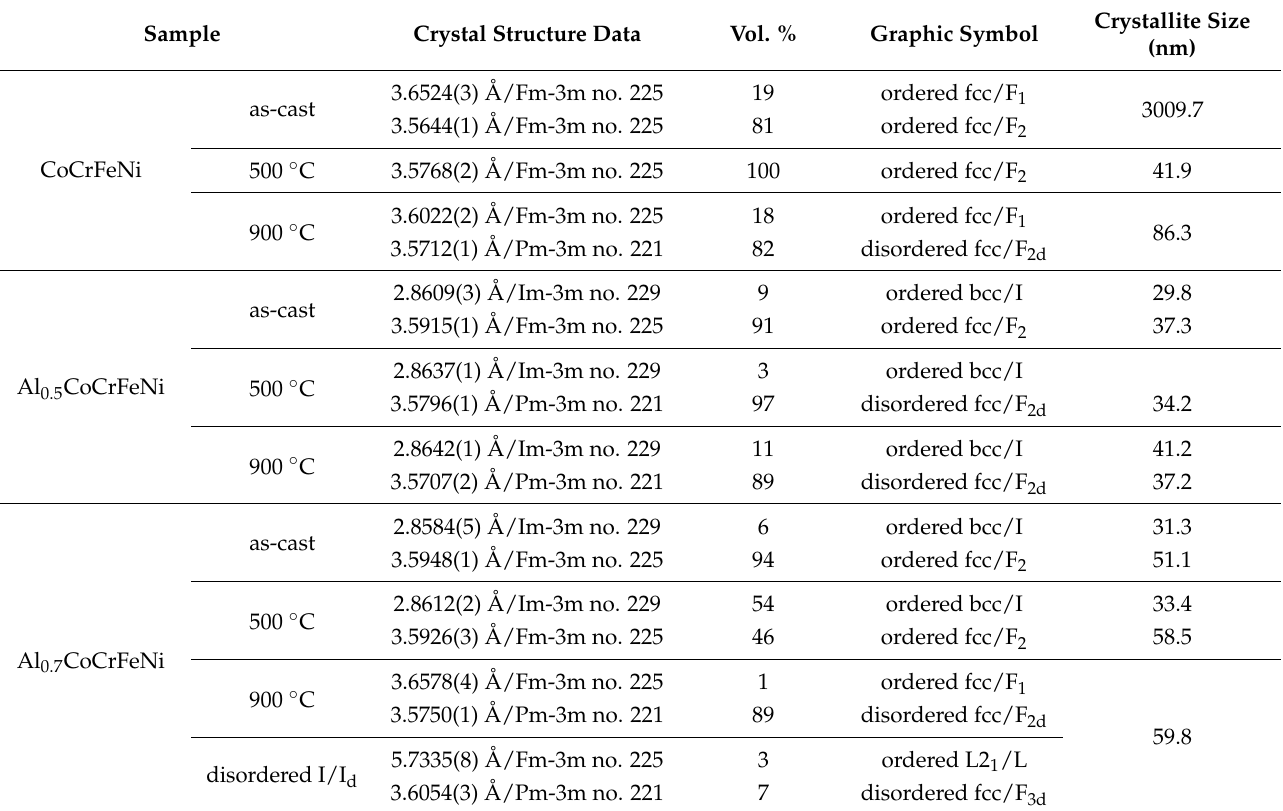
Table 2. Phase analyses carried out by the use of the ICSD database with respect to referenced cubic space groups number, the unit cell parameters, and the percentage of phase volume contribution. Vol % obtained from XRD